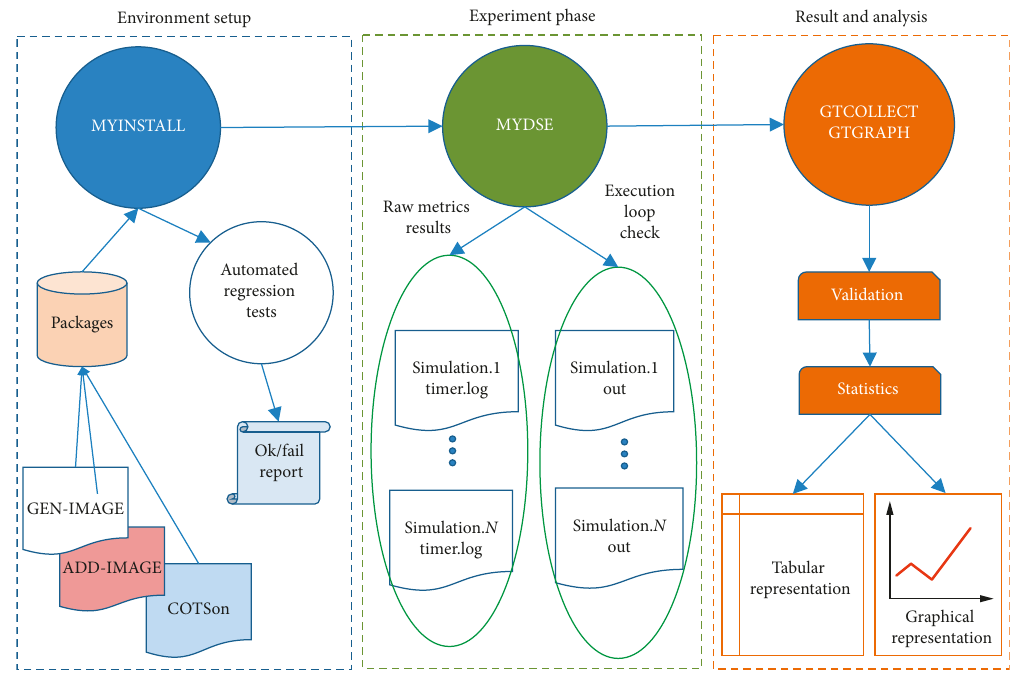
Figure 5: Tool flow of the Design Space Exploration tool. The MYINSTALL tool prepares the whole environment and performs automated regression tests in the end. The MYDSE tool takes care of the experiment loop and the reordering of several output files generated by each simulation. Finally, the GTCOLLECTS and GTGRAPH tools collect the results, perform validation and statistical operations on the results, and plot the data in a tabular or graphical format